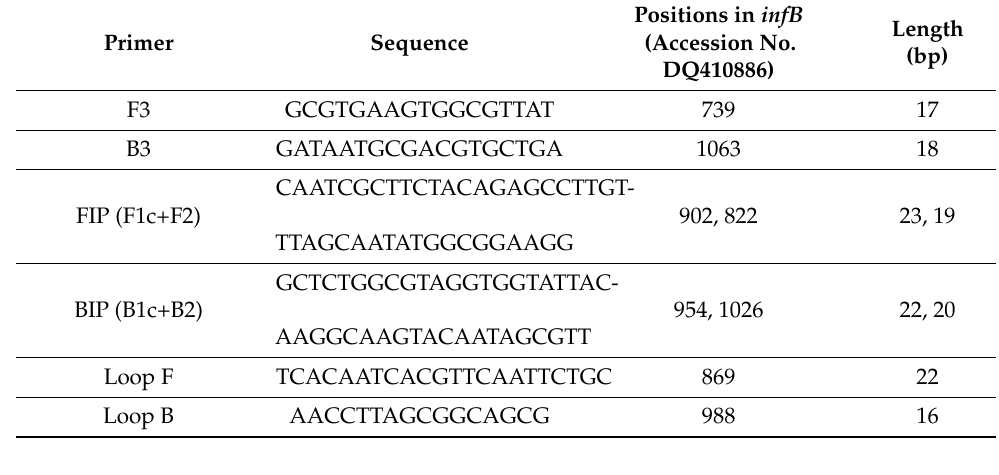
Table 2. Most suitable primer set used for the LAMP assay targeting the infB gene.